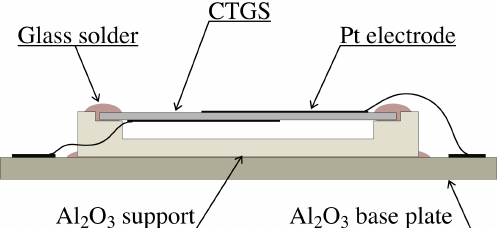
Figure 1. Schematic of housed resonator’s inner design. The CTGS crystal is mounted in a support made of polycrystalline alumina. The support is installed on a single crystal Al 2 O 3 base plate. The CTGS electrodes are connected with the pads using bond wires. All elements are fixed using a glass solder.